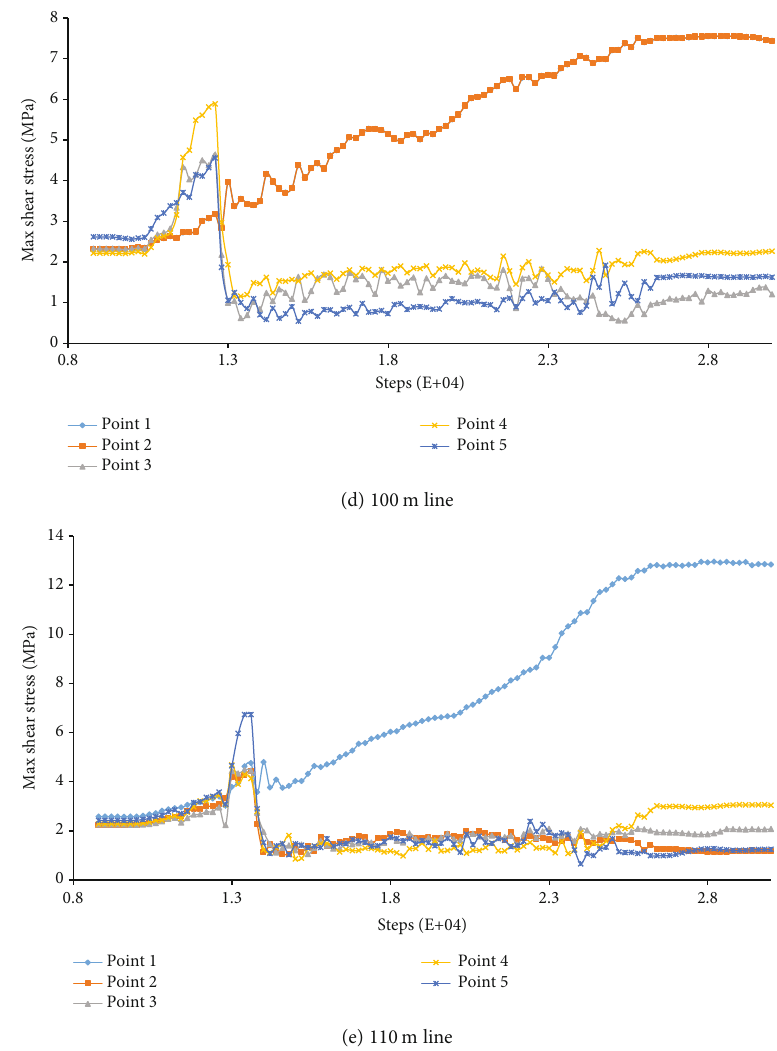
Figure 7: L = 200 m, H = 1 : 5 M shear stress trends.